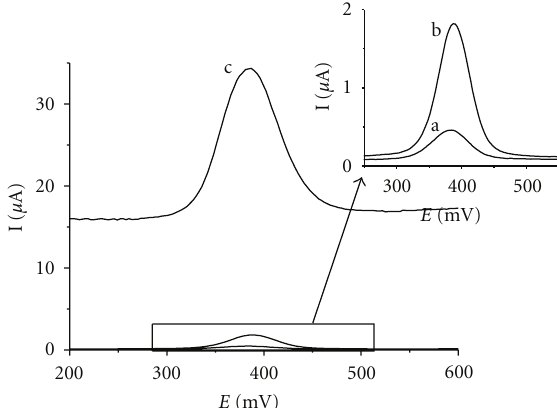
Figure 4: Cyclic voltammograms of rutin on IP/CPE (a), CPE (b), and IL/CPE (c). 0.1mM rutin solution in acetate bu ff er (pH 4.0), scan rate 100mVs − 1 .